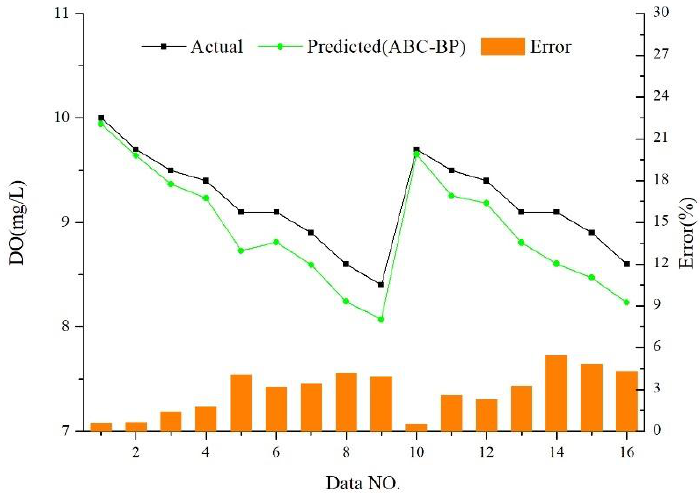
Figure 12. The predicted ABC-BP value and its error percentage.